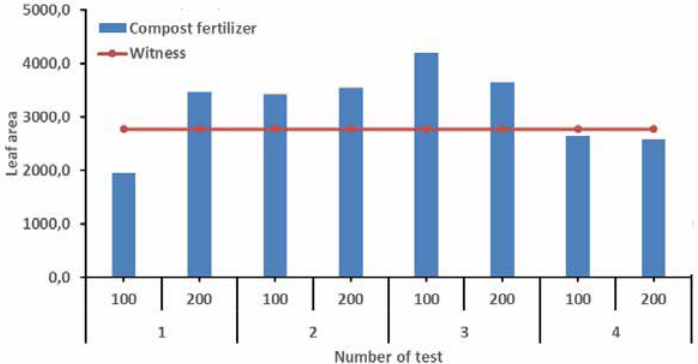
Fig. 2: Average total leaf area per treatments, a = 100g dose, b = 200g dose